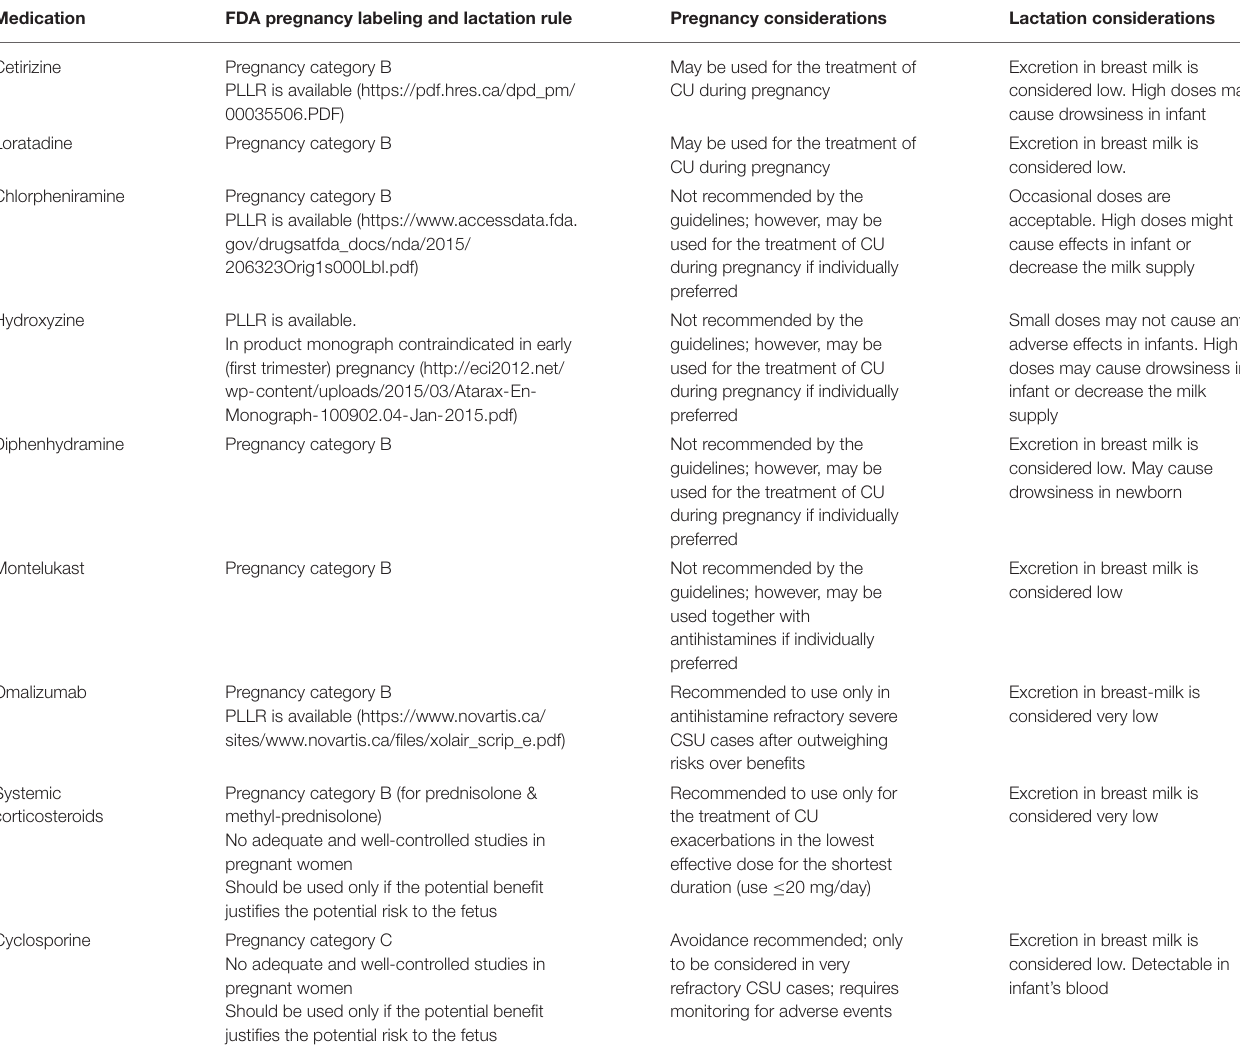
TABLE 2 | Considerations for pregnancy and lactation for the medications used in the treatment of chronic urticarial. Medication FDA pregnancy labeling and lactation rule Pregnancy